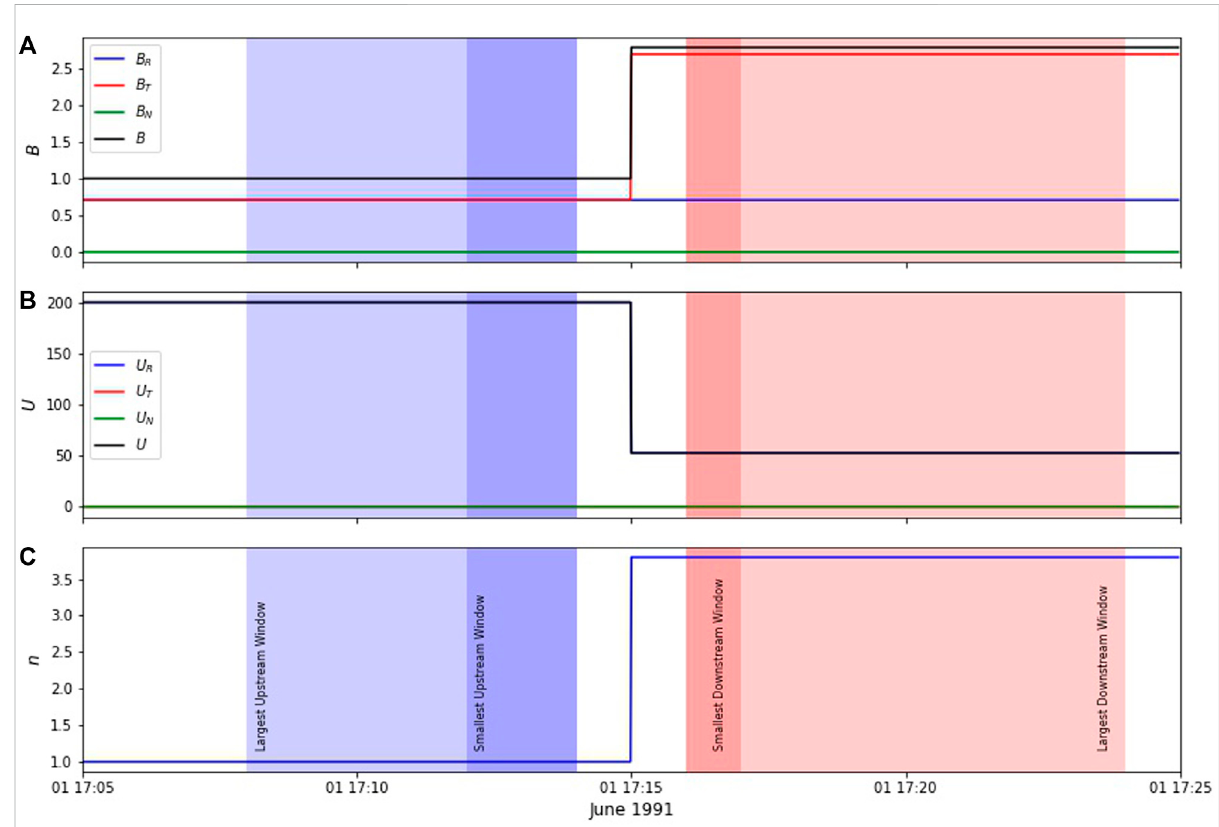
Synthetic measurements for a Rankine-Hugoniot compliant shock with θ Bn = 45 ° and gas compression ratio r gas = 3.8. Panel show magnetic fi eld magnitude and components (A) , plasma bulk fl ow speed (B) and density (C) . The blue (red) shaded areas highlight the windows chosen for upstream (downstream)